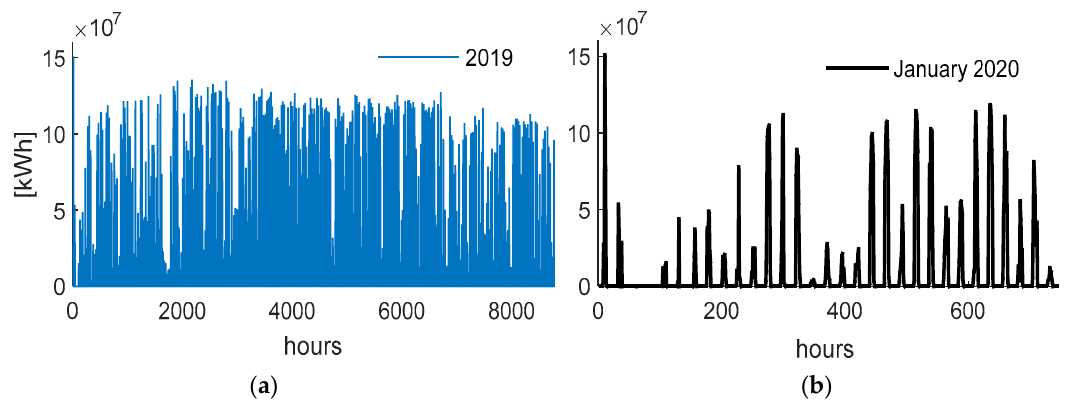
Figure 12. PV 160 MW production ( a ) for 2019 ( b ) for January 2020.